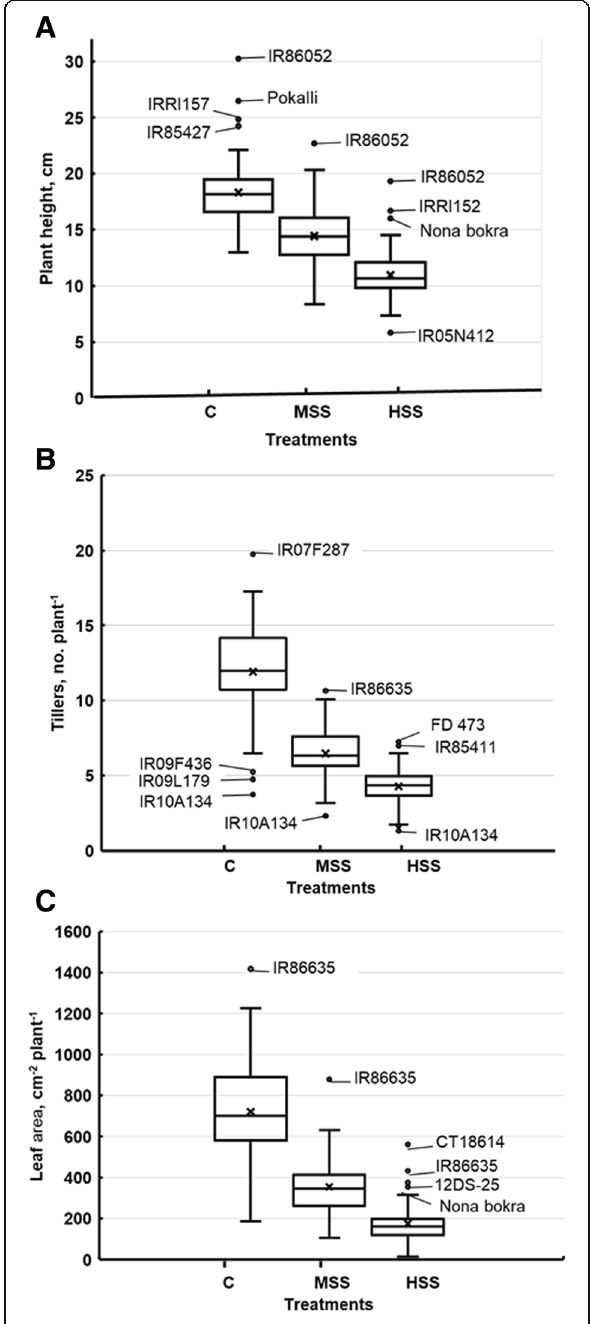
Fig. 1 Box and whisker plots for shoot growth and developmental traits showing natural variation and the effect of different salinity treatments on the average ( a ) plant height, cm ( b ) tillers, no. plant − 1 , and ( c ) leaf area, cm 2 plant − 1 The whisker below the box represents the first quartile (Q1) or the fifth percentile showing the first 25% of data distribution in this range whereas the whisker above the box represents the third quartile (Q3) or 95th percentile showing the last 25% of the data distribution. The length of the box is called interquartile range (IQR) or (25th to 75th percentile), shows 25 to 75% of the data distribution for that particular trait and the horizontal line in the box indicates the median value. The genotypes below the first quartile or above the third quartile are representing outliers in individual traits, are also